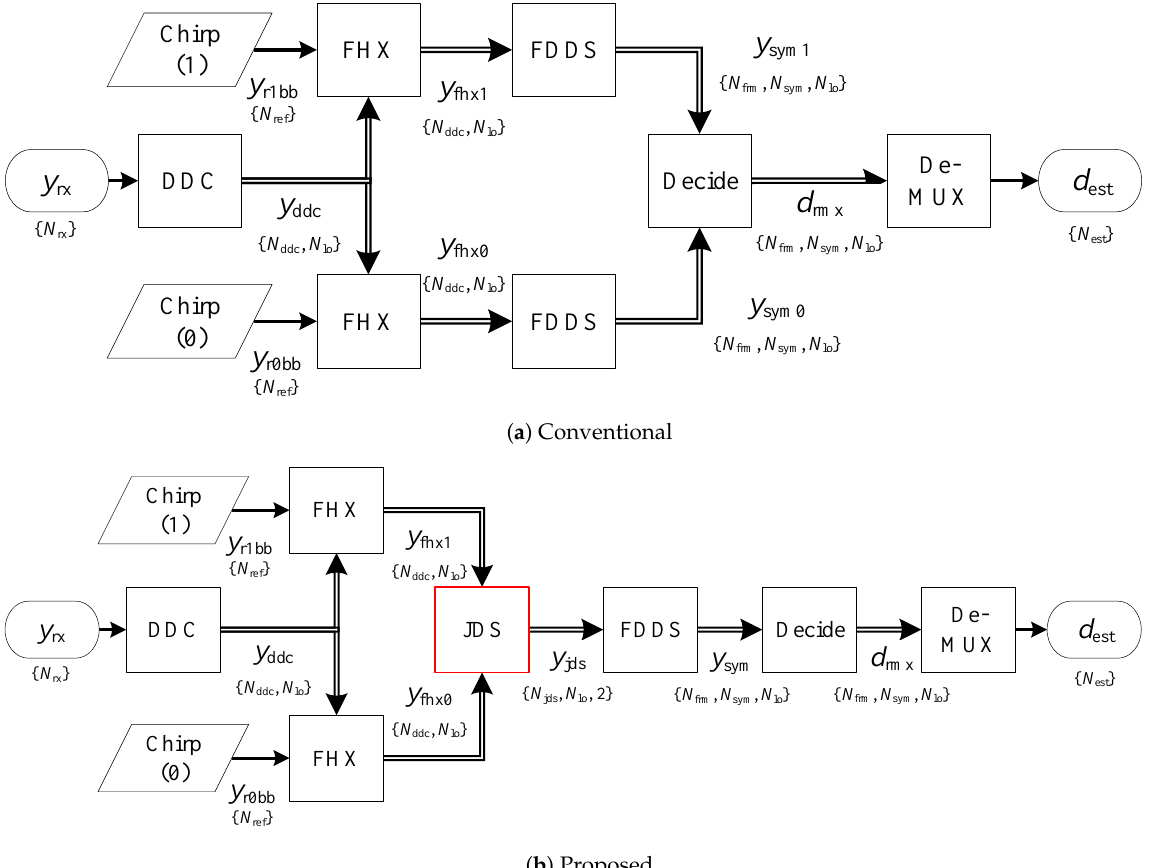
Figure 6. Comparison of the conventional and proposed demodulation as a block diagram in detail. ( a ) In the former case, the received sequence y rx is processed by Digital Down-Coverter (DDC), compressed through a Fast Hilbert Cross-Correlator (FHX), converted into symbol space through Frame Detect & Downsample (FDDS), which is interpreted by a binary decision (Decide) block, and finally assembled into the estimated data output d est through a reverting multiplexer (De-MUX). ( b ) We propose the insertion of a superposition in the compressed sample space through the Join & Downsample (JDS) block that creates a sum signal for symbol timing and a difference signal for symbol